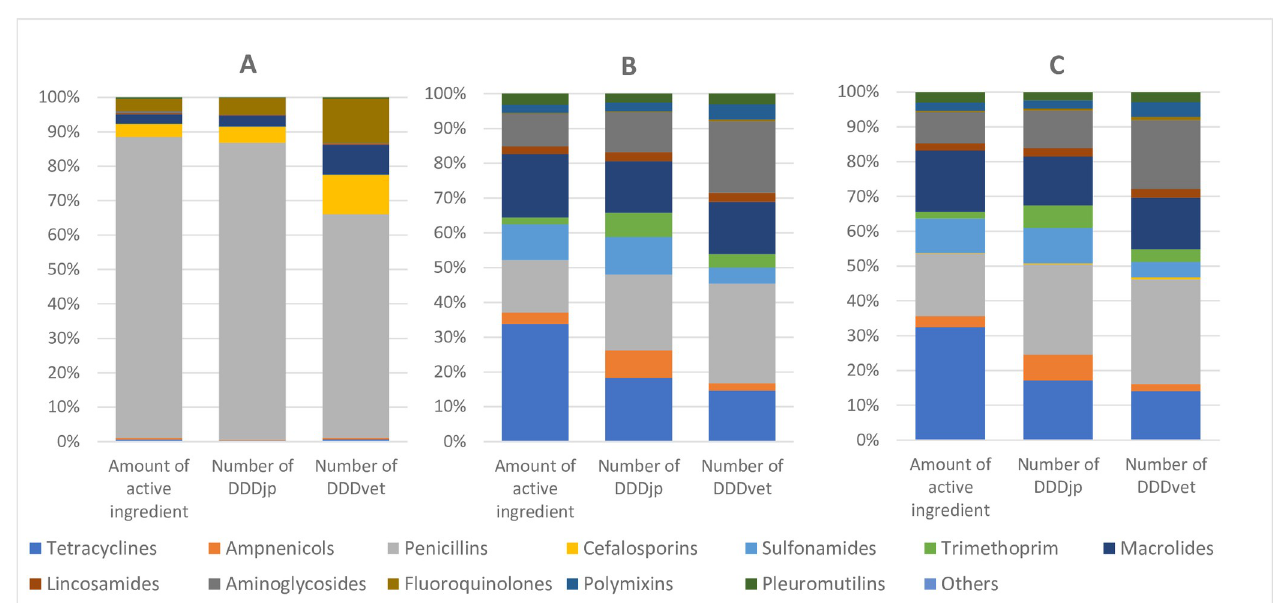
Fig 3. Relative distribution of antimicrobial use by administration route (injection (A), oral (B) and total (C)) between antimicrobial classes measured either as the weight of active ingredient or as the number of defined daily doses (DDDs), calculated using Japanese values (DDDjp) and European values (DDDvet) published by the European Medicine Agency